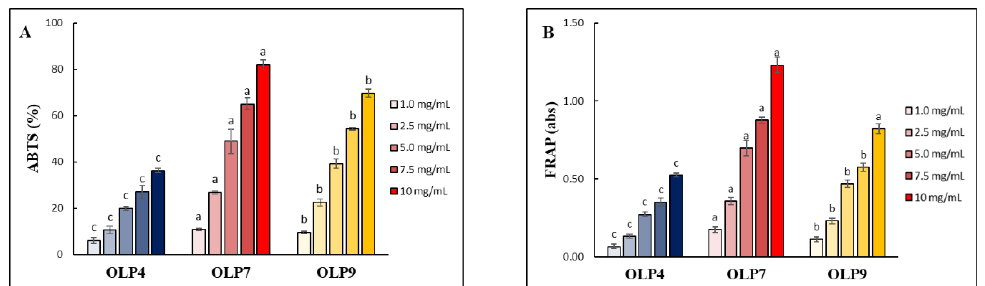
Figure 5. ( A ) ABTS radical scavenging activity (ABTS-RSA) and ( B ) ferric reducing antioxidant power (FRAP) of polysaccharides from okra leaves (OLPs) at various concentrations. The color intensity in the graph denotes increasing concentration from 1.0 to 10 mg/mL. a–c Superscripts represent significant differences (Tukey’s test, p < 0.05).